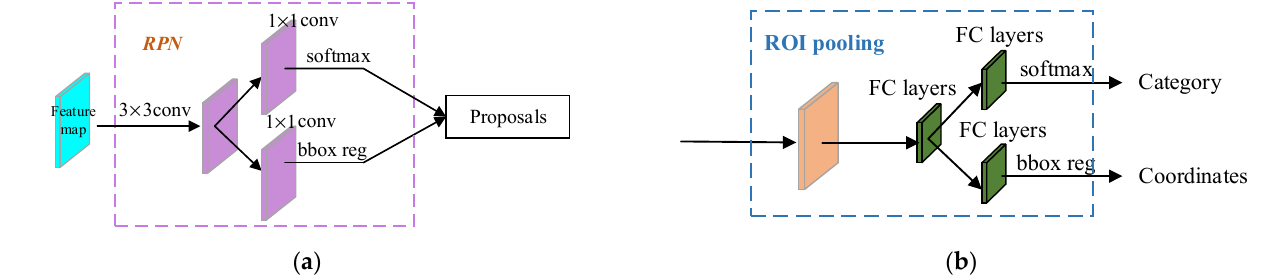
Figure 3. The architectures of the RPN and POI pooling, which are depicted in ( a ) and ( b ), respectively; ‘bbox reg’ refers to ‘bounding boxes regression’.